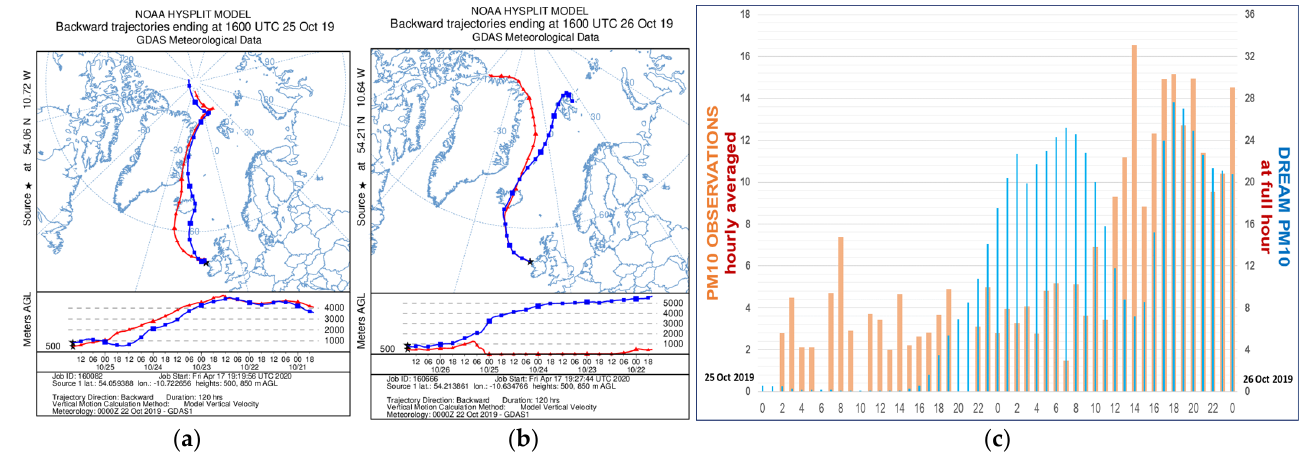
Figure 21. The same explanation as for the Figure 18. Here we show the trajectories for 2 different release heights. The evidence of dust arriving Mace Head station (Ireland) 25–26 October 2019; ( a ) and ( b ) NOAA HYSPLIT backward trajectories for 25 and 26 October 2019, respectively; and ( c ) observed PM 10 (orange bars) and model surface PM 10 dust concentrations (blue bars) ( µ g m − 3